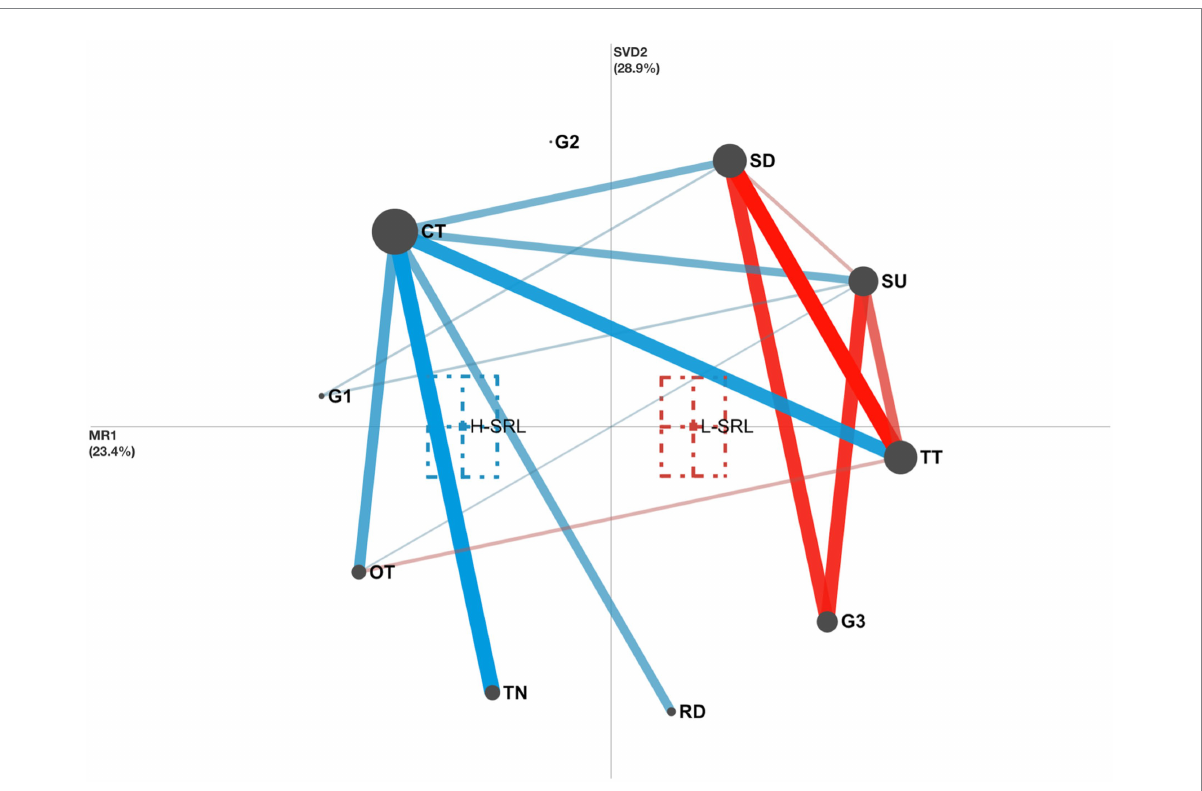
FIGURE 12 Comparison between the H-SRL (blue) and L-SRL (red) groups. Blue edges represent stronger associations in the H-SRL network; red edges represent stronger associations in the L-SRL